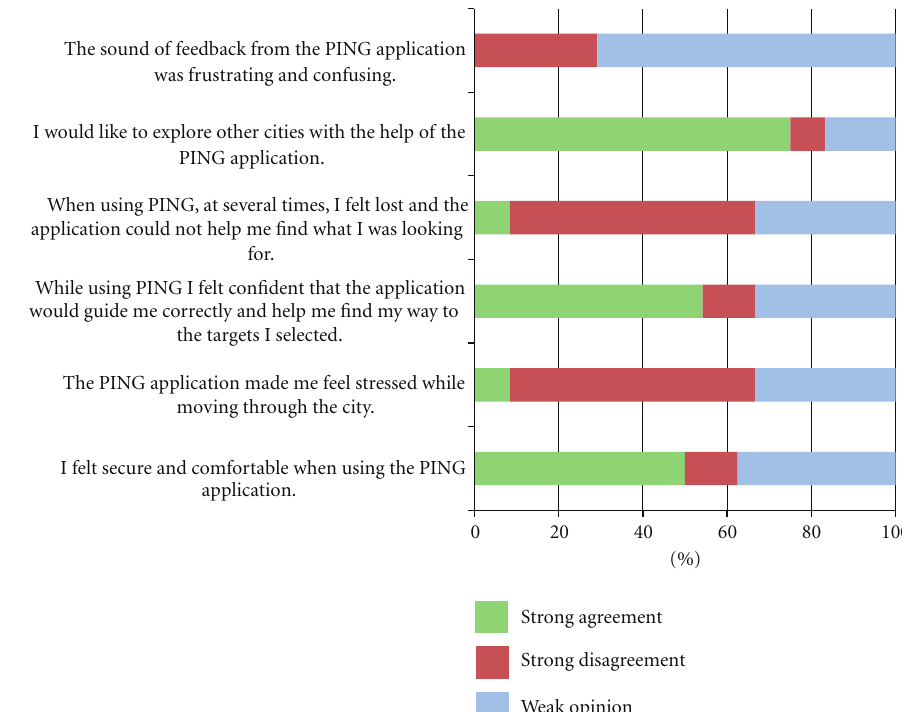
Figure 5: Users level of agreements to complementary statements in the